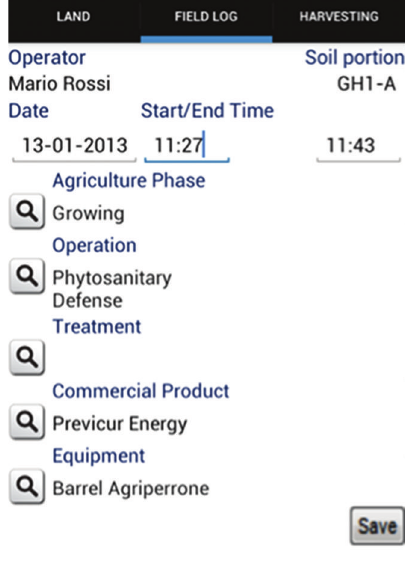
Figure 6: The agronomist’s Android app